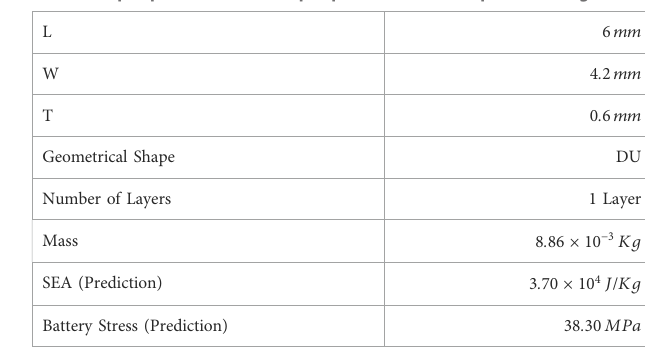
TABLE 5 Input parameter and output prediction of the optimum